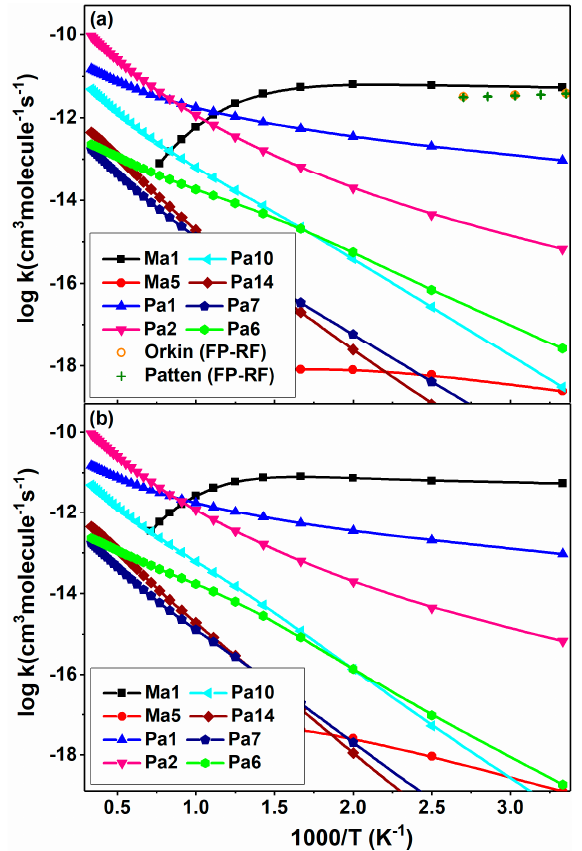
Figure 7. Rate constants of the major channels for 2-BTP + OH at 300–3000 K at the pressures of ( a ) 0.1 atm and ( b ) 1 atm in N 2 . Note: orange circles and olive crosses indicate the rate constants of 2-BTP + OH at 100 and 30 torr measured by Orkin et al. and Patten et al. respectively.